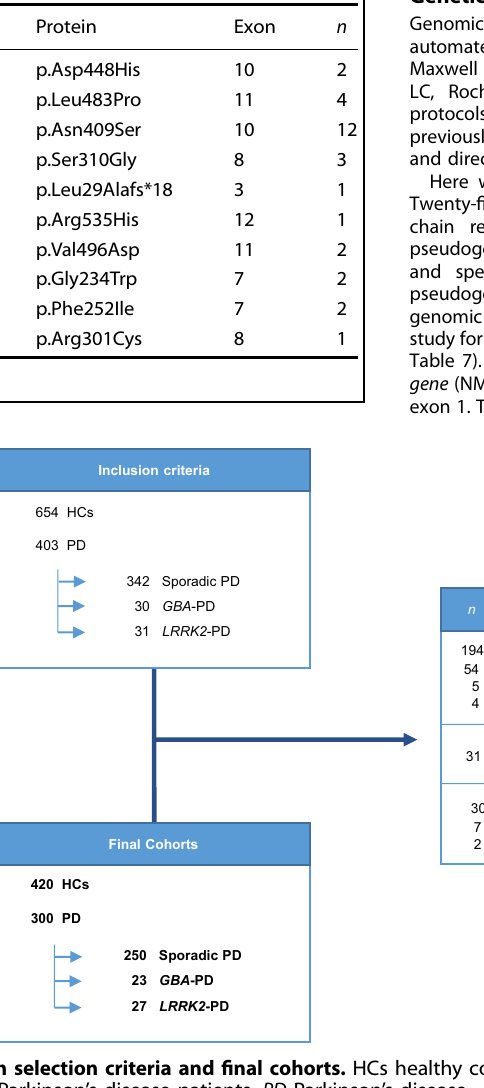
Table 4. List of GBA pathogenic variants considered for the inclusion of patients in the GBA -associated Parkinson ’ s disease group.